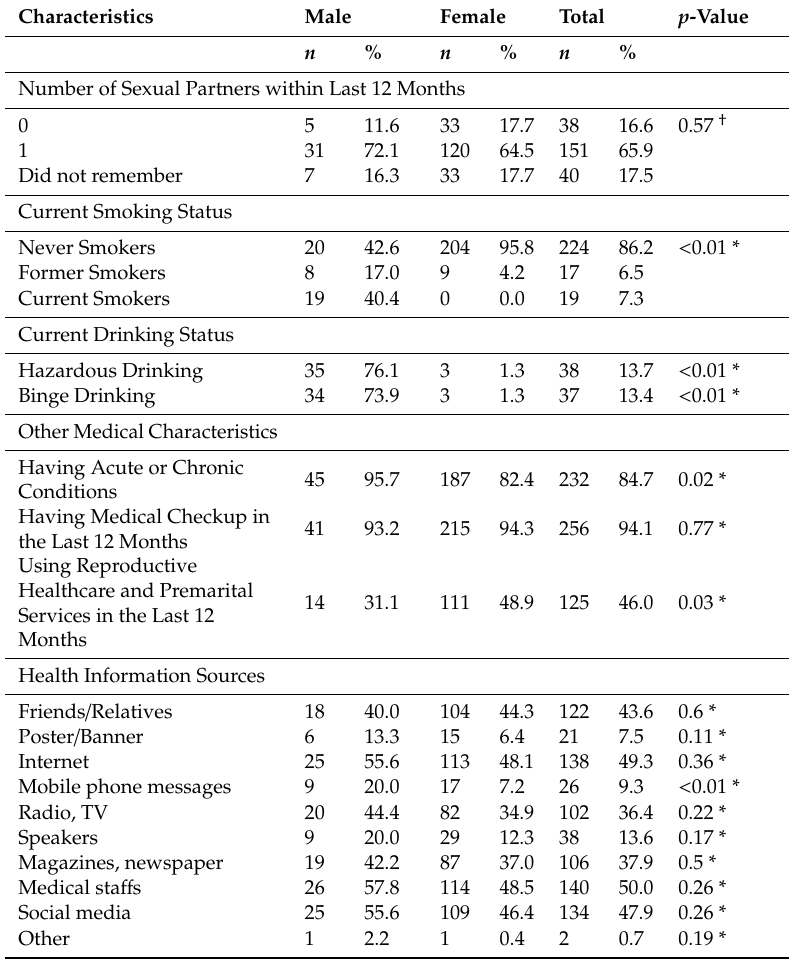
Table 2. Health status and health risk